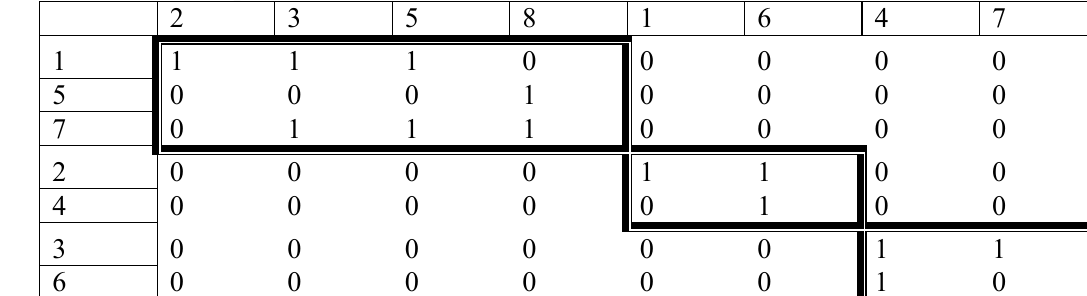
Final solution matrix X for problem 1